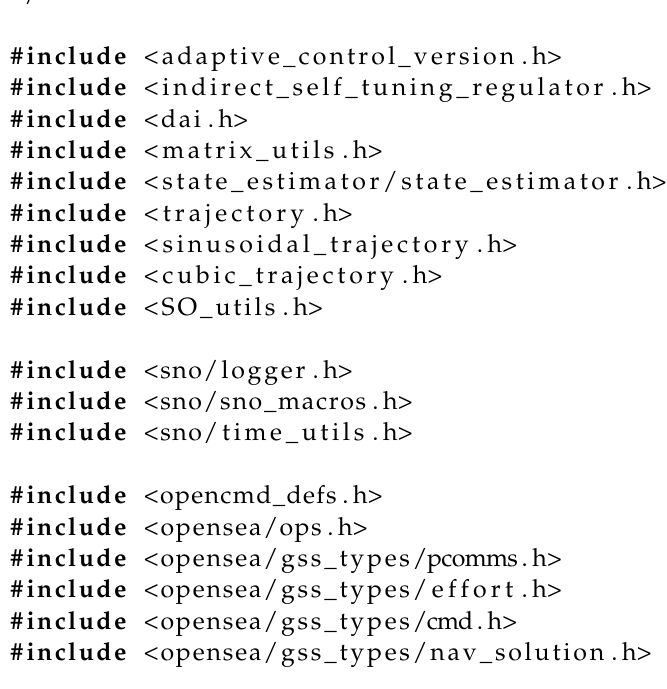
plot ( psi , psi_dot ) axis